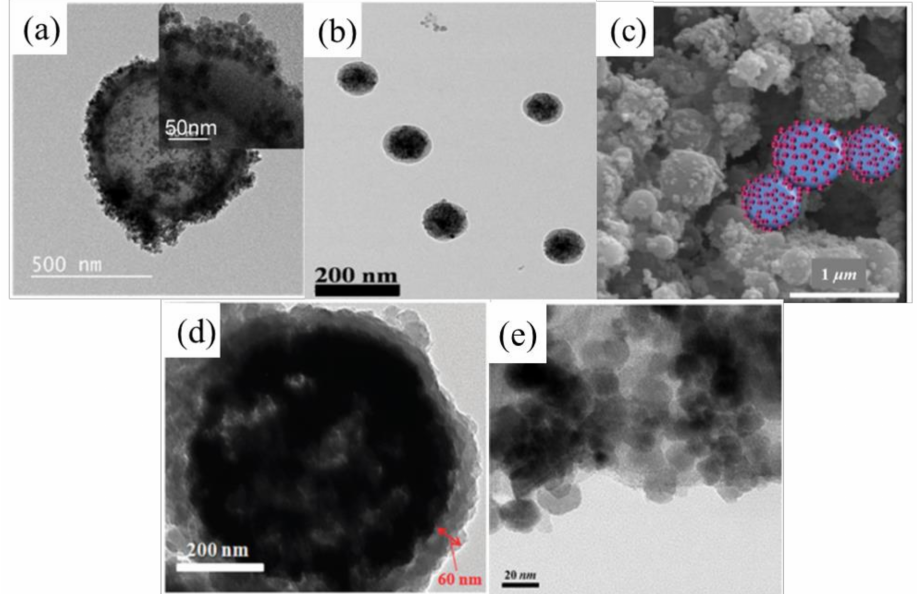
Figure 2. Images of iron-based magnetic polymer composites: TEM images of ( a ) hollow polydivinylbenzene@Fe 3 O 4 (Choi et al. [44], ©American Chemical Society, 2019), ( b ) polystyrene (PS)/Fe 3 O 4 (Kim et al. [46], ©The Polymer Society of Korea and Springer, 2018), ( d ) polypyrrole- coated Fe 3 O 4 hybrid particles (Choi et al. [51], ©The Royal Society of Chemistry, 2013), and ( e ) PDPA/Fe 3 O 4 composite (Dong et al. [52], © Springer Nature, 2018). ( c ) Scanning electron microscopy image of PS/Fe 3 O 4 particles (Choi et al. [47], ©WILEY-VCH Verlag GmbH & Co. KGaA, Weinheim, Germany,